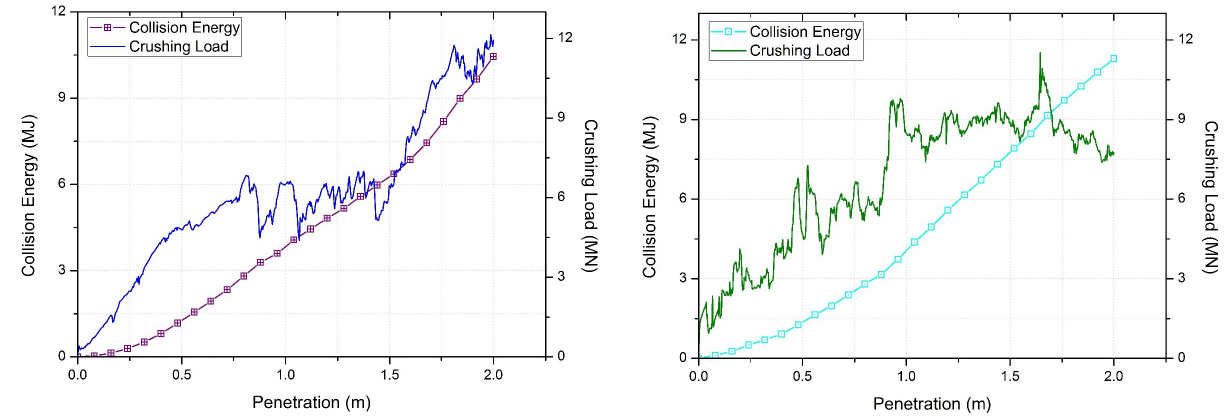
Figure 4: Energy and load characteristic of collision on side shell. but the tearing on side zone was bigger than collision on longitudinal component.